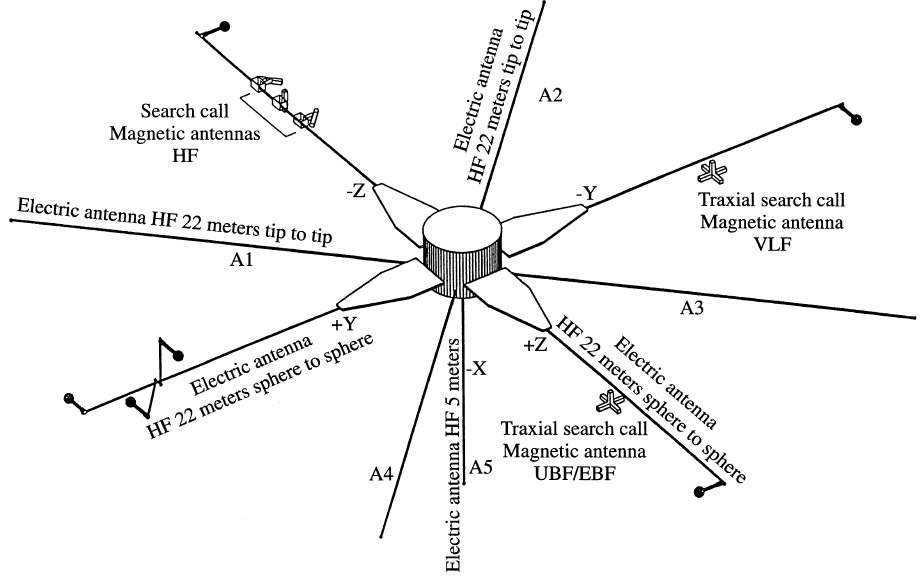
Fig. 1. Description of the electric and magnetic sensors on the spacecraft